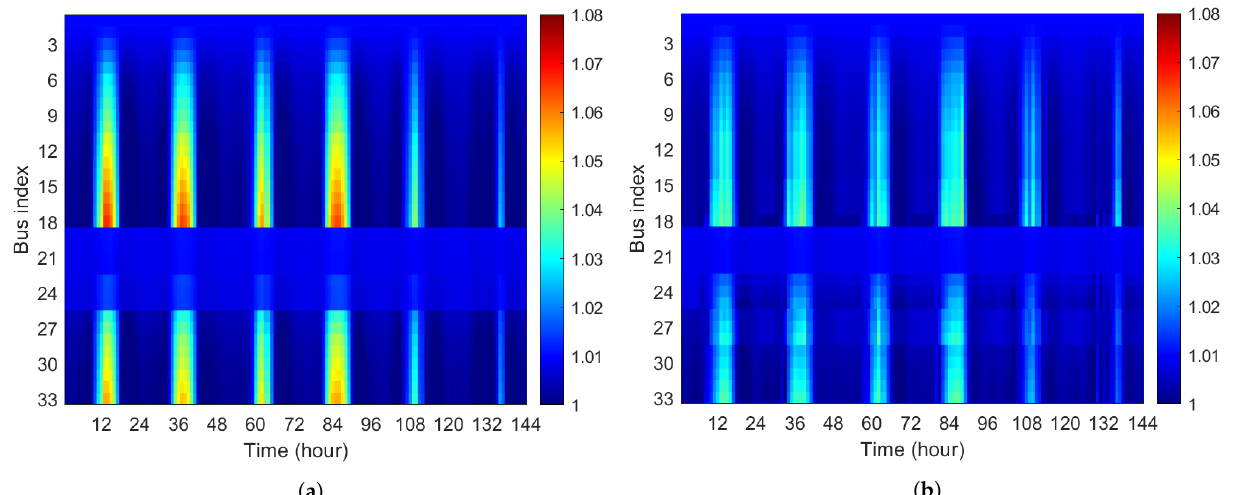
Figure 6. Voltage profile for six test days in January. ( a ) Voltage profile without control (Baseline); ( b ) voltage profile with the proposed HMA-DRL